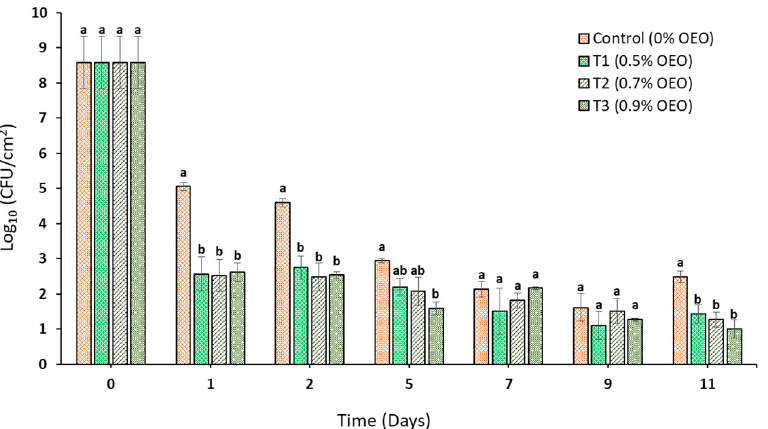
Figure 3. Growth of Salmonella on mango surfaces at 25 °C and 95% RH after coating treatments. Numbers at day 0 are the bacteria population before coating. Error bars represent the standard errors of the means. Different letters above bars indicate significant differences in the mean for that sampling period ( p ≤ 0.05).